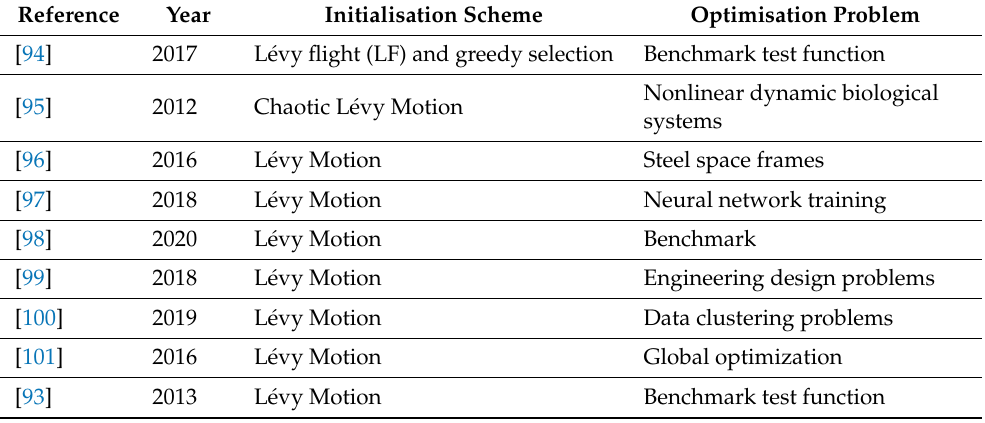
Table 7. Summary of levy flight